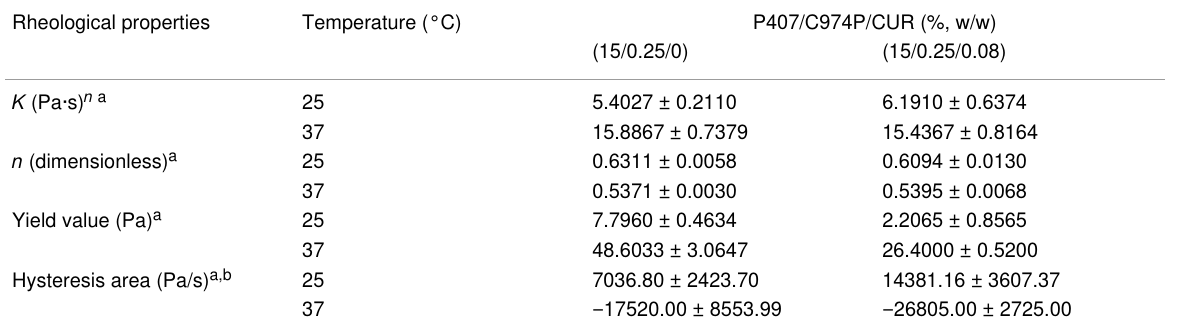
Table 3: Consistency index ( K ), flow behavior index ( n ), yield value and hysteresis area at 25 and 37 °C for systems containing P407, C974P with and without